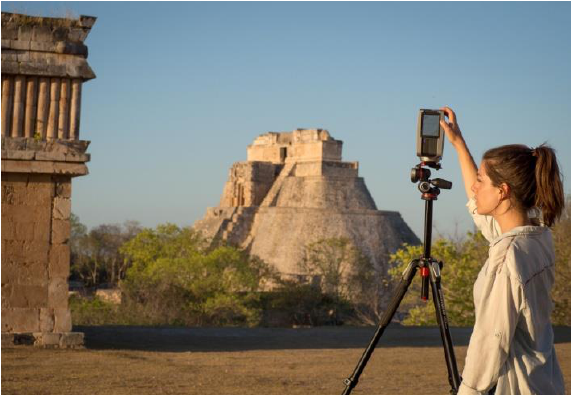
Figure 3. Laser scanning data capture at Uxmal, Mexico. (Photo R. Martínez 2018).